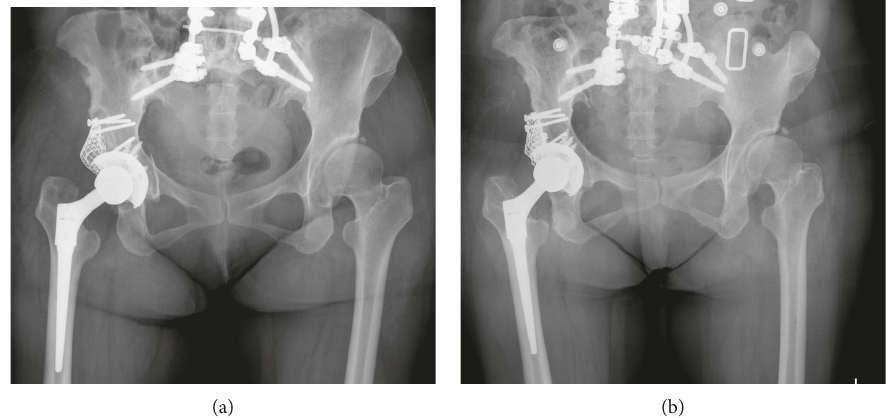
Figure 2: Case 1 postoperative hip X-rays. (a) Immediately after operation. (b) Nine years after operation. There were no clinical signs of implant loosening in the hip X-ray.